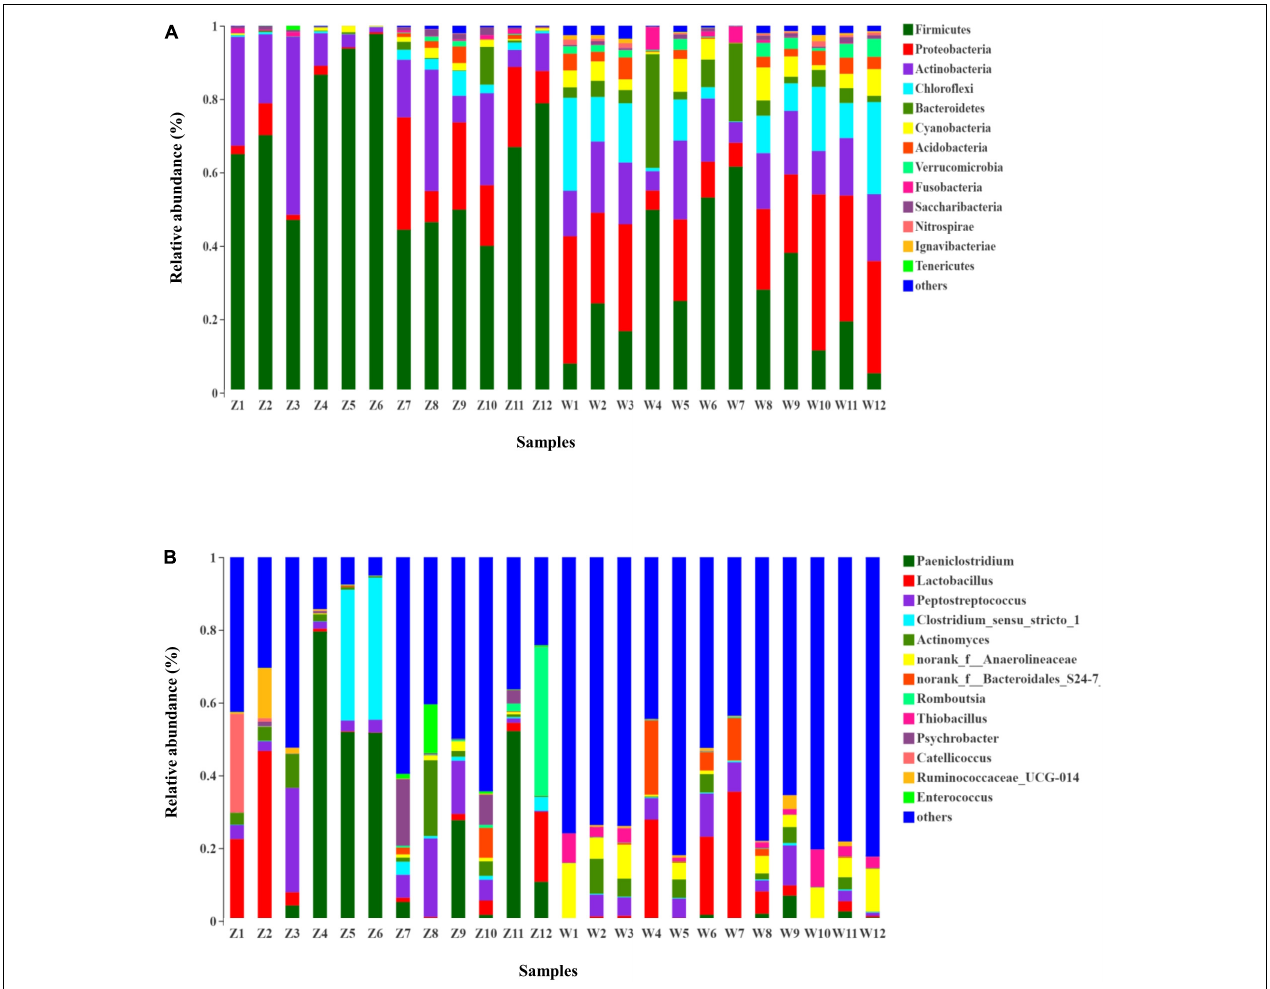
FIGURE 1 | Microbial structure of all fecal samples at phylum and genus levels. (A) Bar-plots showing the abundance and distribution of the 11 most abundant phyla. (B) Bar-plots showing the abundance and distribution of the 11 most abundant